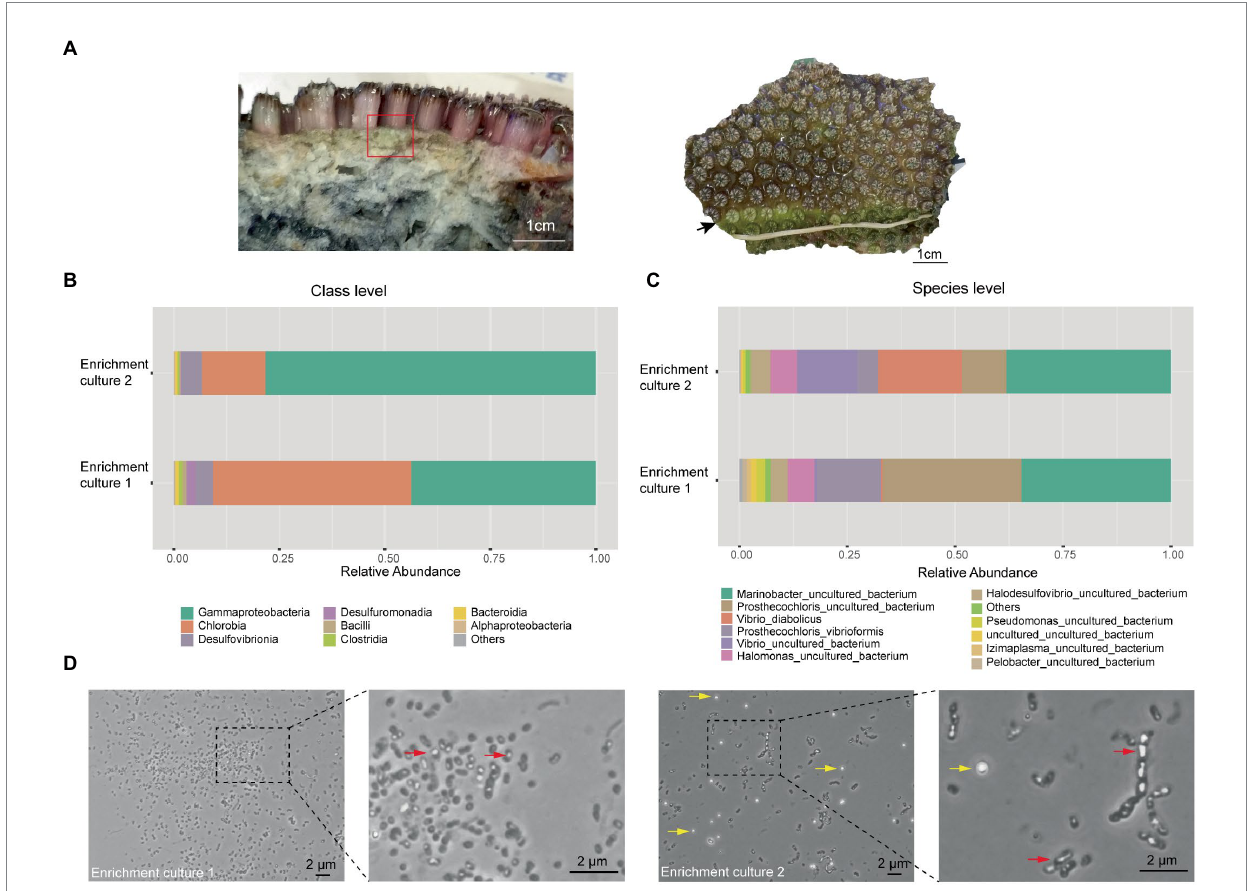
FIGURE 1 Prosthecochloris cells were enriched from the skeleton of Galaxea fascicularis . (A) Lateral and frontal views of the Galaxea fascicularis skeleton. The red rectangle indicates the region of the skeleton sampled for enrichment culture. The black arrow indicates a green layer in the corallites after polyp bleaching. Relative abundance of major microbial taxa in enrichment cultures at class level (B) and at species level (C) . (D) Cell morphology of Prosthecochloris cells. Red arrows indicate gas vesicles in cells and yellow arrows indicate sulfur granules outside